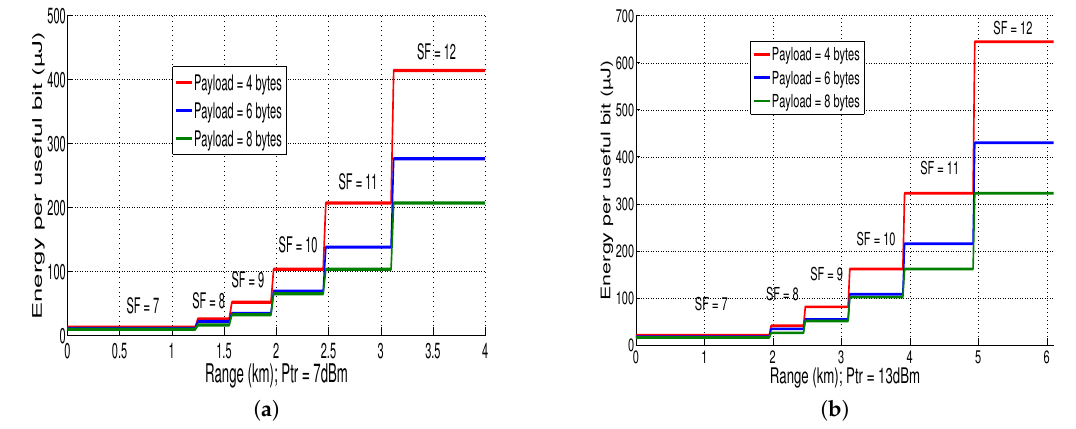
Figure 13. ( a ) E bit vs. LoRaWAN range at different payloads ( P Tr = 7 dBm); and ( b ) E bit vs. LoRaWAN range at different payloads ( P Tr = 13